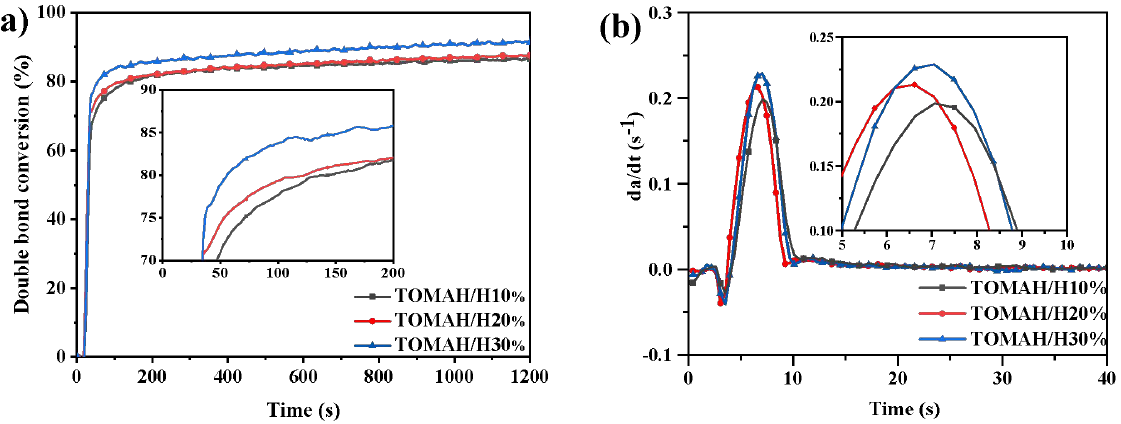
Figure 2. ( a ) Double-bond conversions and ( b ) polymerization rates of the UV-curable TOMAH/H resins. Table 2. UV-curing parameters and physical properties of the TOMAH/H resins. Samples